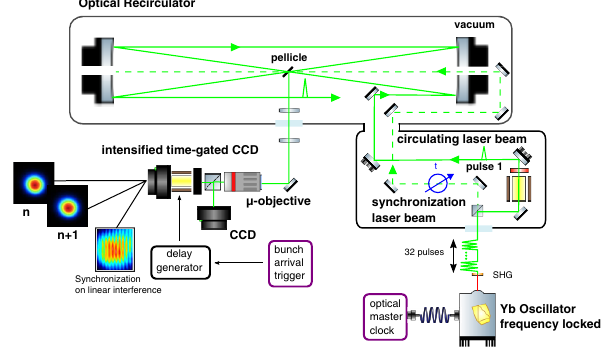
FIG. 13. Principle scheme of the synchronization and align- ment tool. A recirculating laser beam (solid line) is injected inside the recirculator from the injection chamber. A thin beam-splitter plate labeled “ pellicle ” images the spot of each pass at the IP. Finally, the laser spot image is recorded pass after pass by one dedicated imaging system composed of a micro-objective, an intensified time gated CCD and control system (CCD, trigger, delay generator). For synchronization purposes, the synchroni- zation laser (dashed line) is also injected from the injection chamber onto the electron beam axis. Consequently interference pattern is imaged on the pellicle.